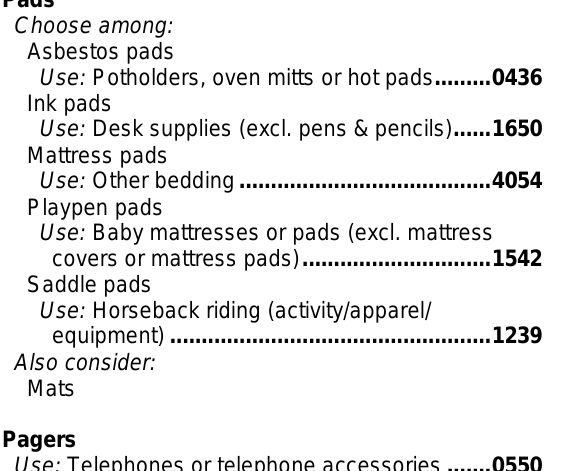
Paddles, table tennis Use : Table tennis (activity/apparel/equipment) .. 1269